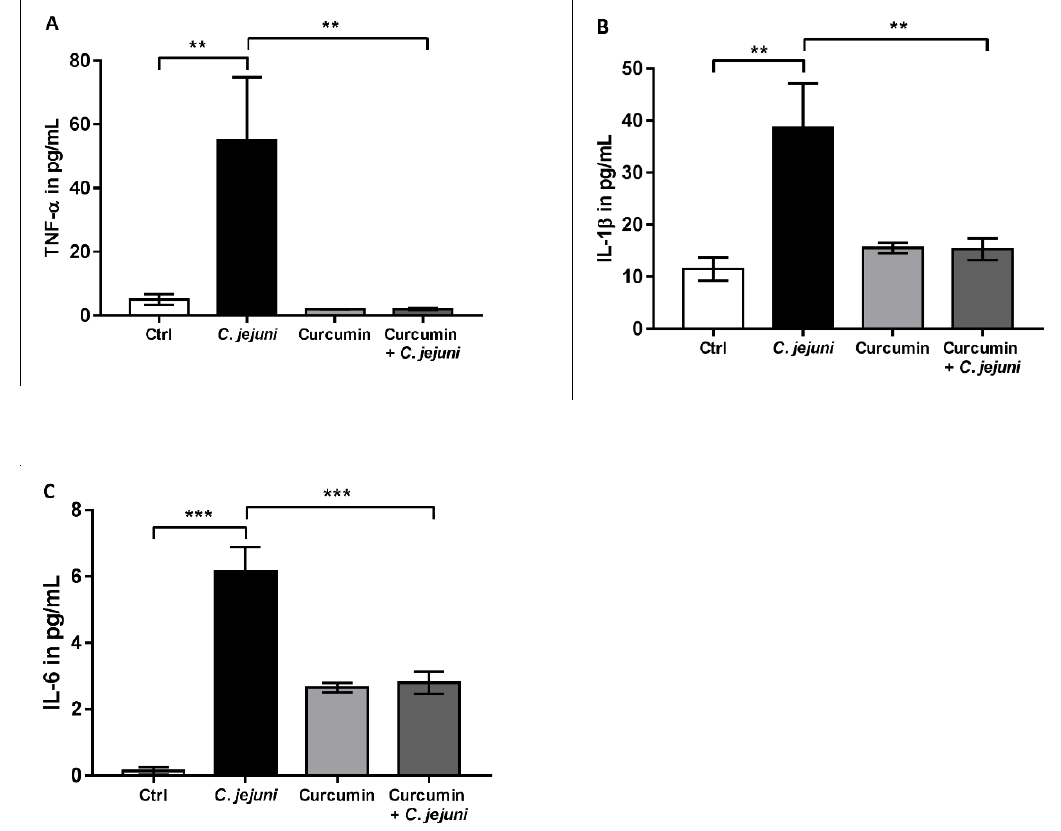
Figure 5. Cytokine release in co-cultures after C. jejuni infection. ( A ) Tumor necrosis factor- α (TNF- α ), ( B ) Interleukin-1 β (IL-1 β ), and ( C ) Interleukin-6 (IL-6) secretion after treatment with curcumin in